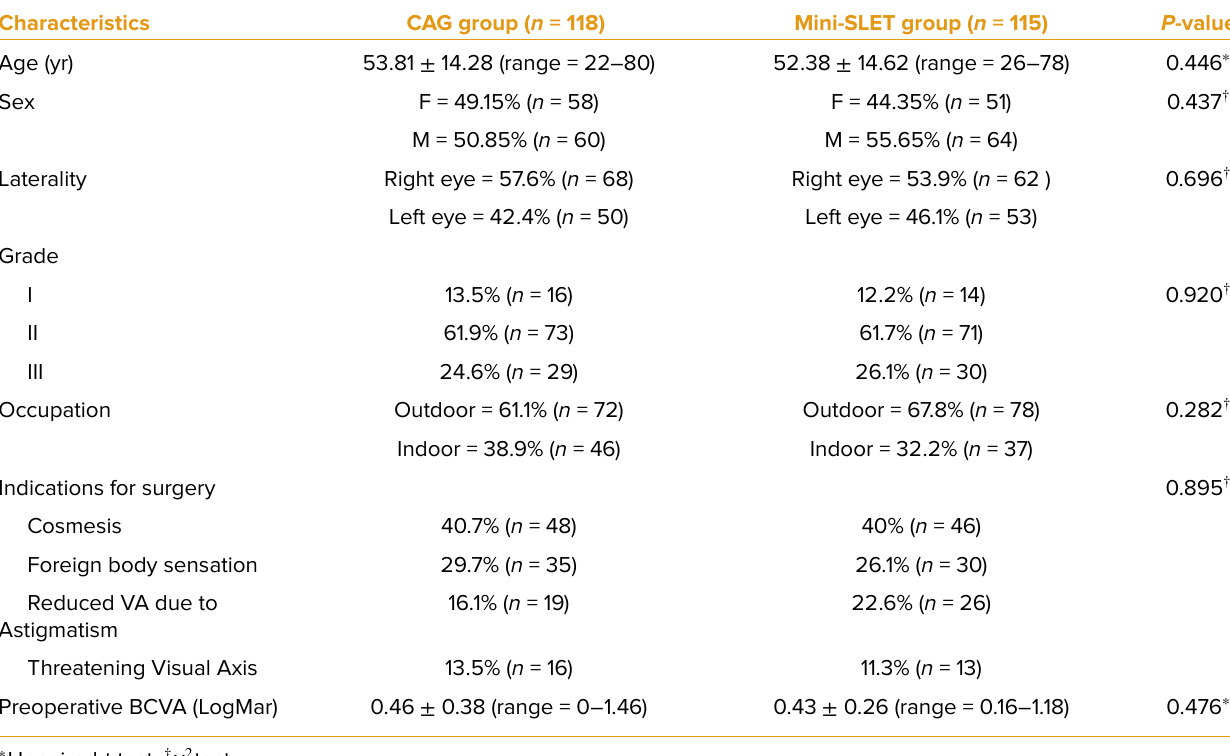
Table 1. Comparison of baseline characteristics between the CAG Group and the mini-SLET group Characteristics